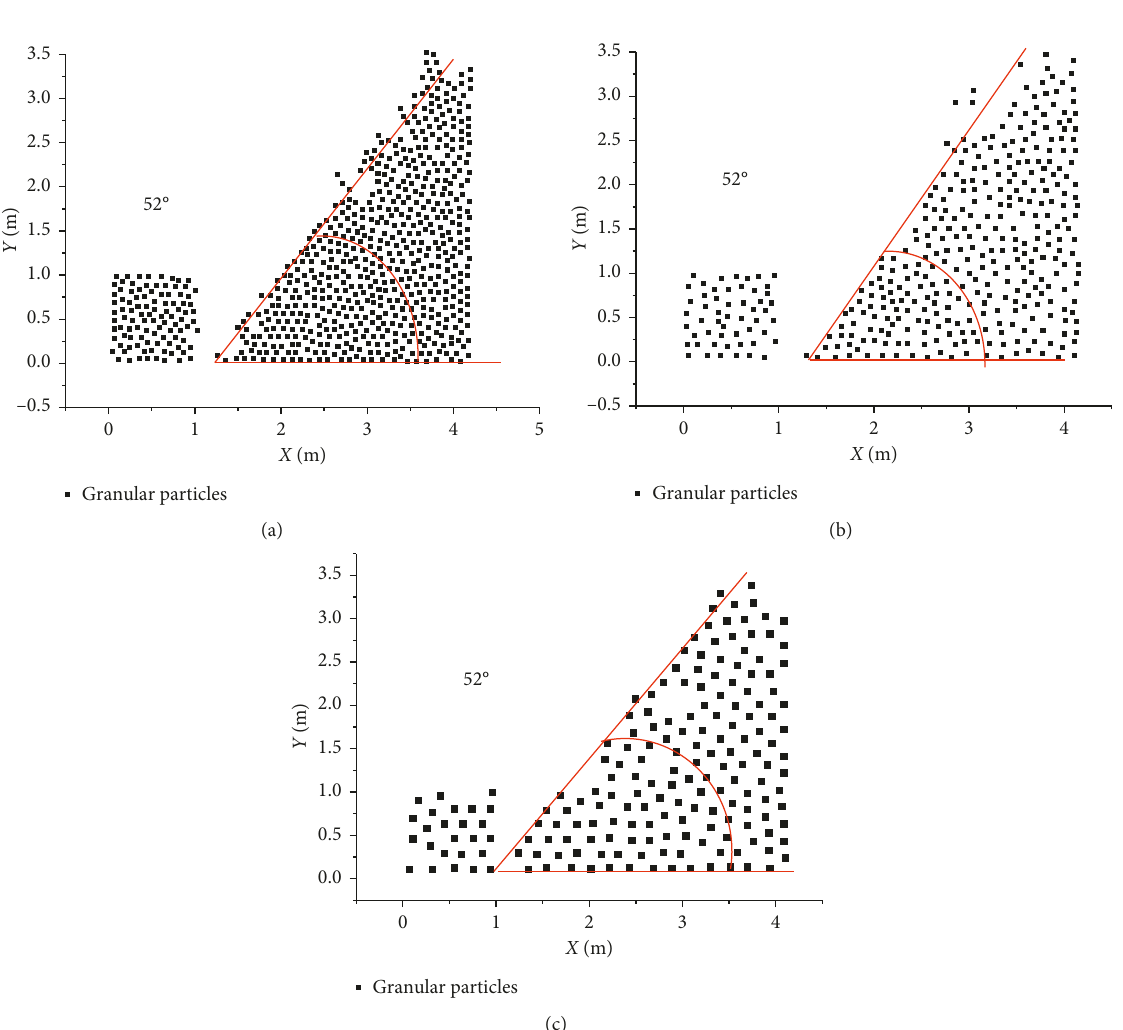
Figure 13: The relationship between the particle size and the slip surface. (a) 0.1m particle size. (b) 0.1 m–0.2m particle size. (c) 0.2m particle